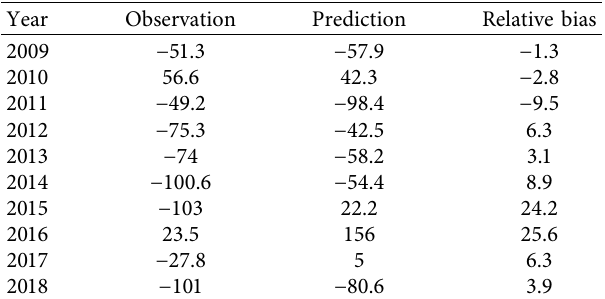
Figure 7: Observed (black line) and predicted (green line) rainfall anomaly in the western mountainous region from 1979 to 2018 (units: mm). The lines before the blue dashed line denote the rainfall from the cross-validation test. The lines after the blue dashed line denote the rainfall from the independent sample test. Table 2: Predicted and observed summer rainfall anomaly (units: mm) and relative bias (units: 100%) of independent sample return test from 2009 to